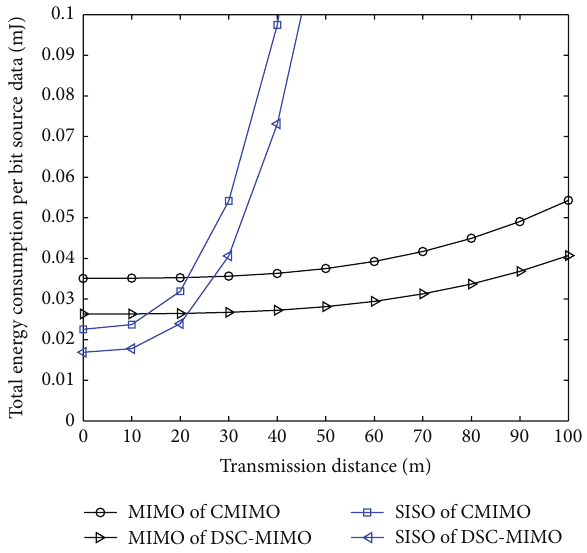
Figure 8: The energy efficiency of DSC-MIMO and CMIMO in different transmission